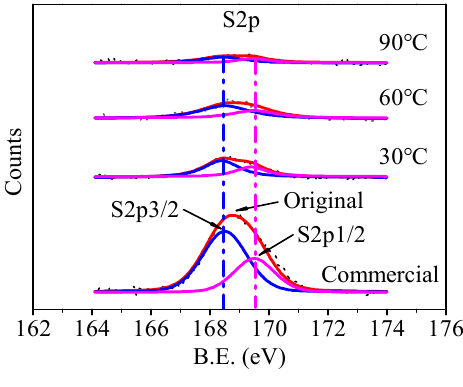
Figure 5. XPS spectra of S2p in Li 2 CO 3 Table 1. Composition of Li 2 CO 3 on surface and in